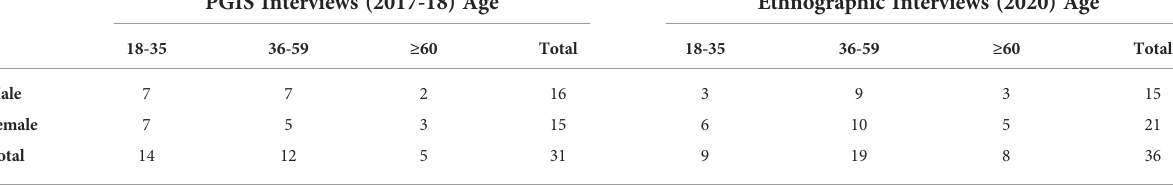
TABLE 1 Age and sex distribution of participants in PGIS mapping interviews (2017-2018) and ethnographic interviews